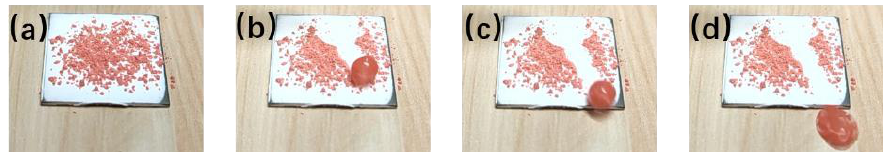
Figure 9. The modification of Nano SiO 2 and micron ZnO.